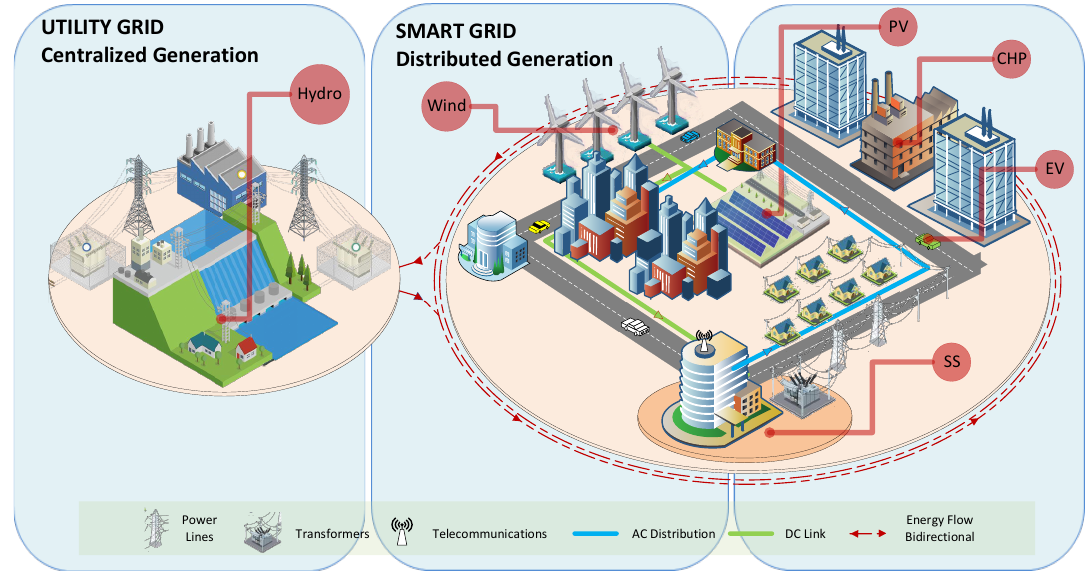
Figure 2. Schematic research showing the SG components.